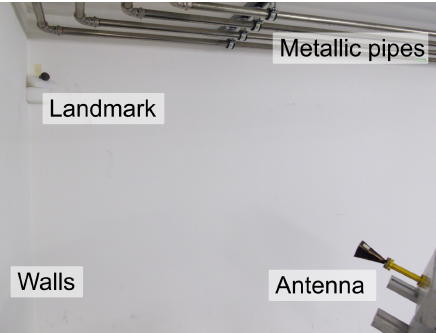
Figure 7. Real indoor set-up for low-Q and high-Q landmarks. Only the latter appears on this image. The received backscattered wave in the time domain is presented in Figure 8a, whereas the frequency response is displayed in Figure 8b. For this case, both the time-gating and RPCA can retrieve the landmark’s response, although the small window span used for the time-gating approach should be pointed out, of 400 ps.